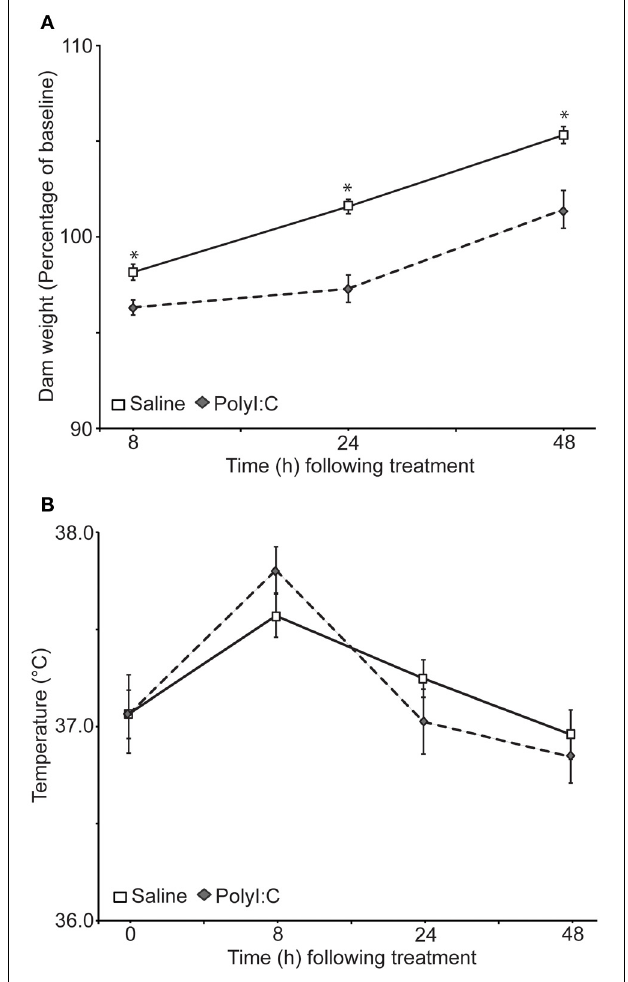
FIGURE 1 | Effects of gestational day 15 saline- ( n = 17) or polyI:C-treatment ( n = 16) on the body weight (A) and temperature (B) of the dams. Weight and temperature were taken 0, 8, 24, and 48h after polyI:C injection. (A) Weight of the dams as a percentage of their baseline weight. PolyI:C-treated dams displayed significantly less weight gain relative to saline-treated dams, ∗ p < 0 . 05. The two groups did not differ on initial body weight at time 0. (B) Rectal temperature of the dams did not differ significantly between the groups at any time point, although a significant main effect of time was observed. Temperatures were higher in both groups 8h after treatment.